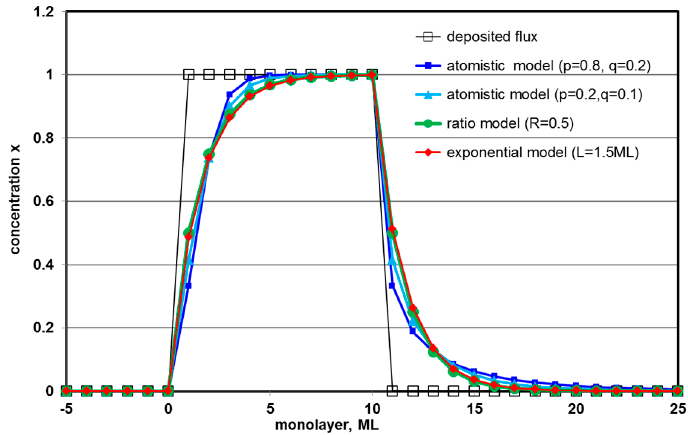
Figure 8. Comparison of compositional profiles from different segregation models for a quantum well nominally 10 monolayers wide.